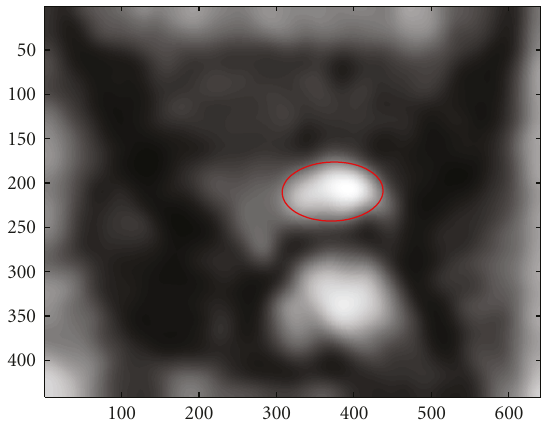
Figure 18: Selected feature map ( RG (3,7)) by maximum activity and segmentation.